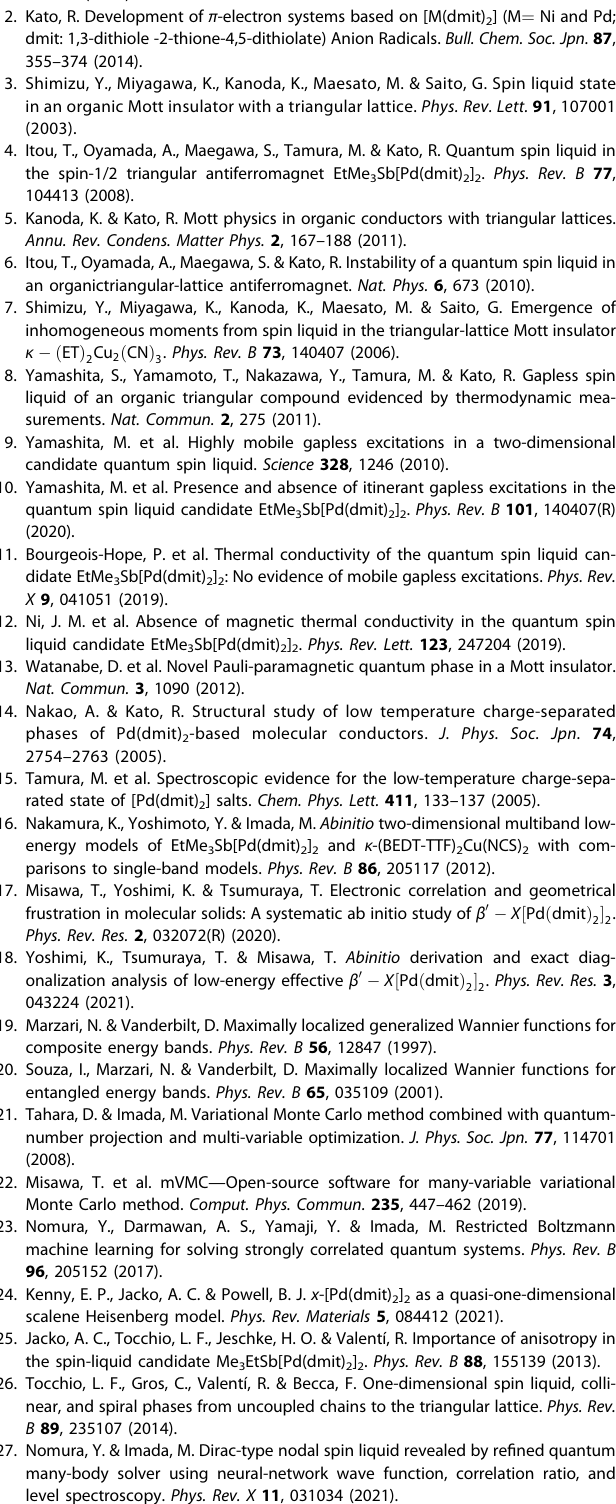
Table 2. Effective exchange parameters evaluated from the ab initio parameters for X [Pd(dmit) 2 ] 2 .